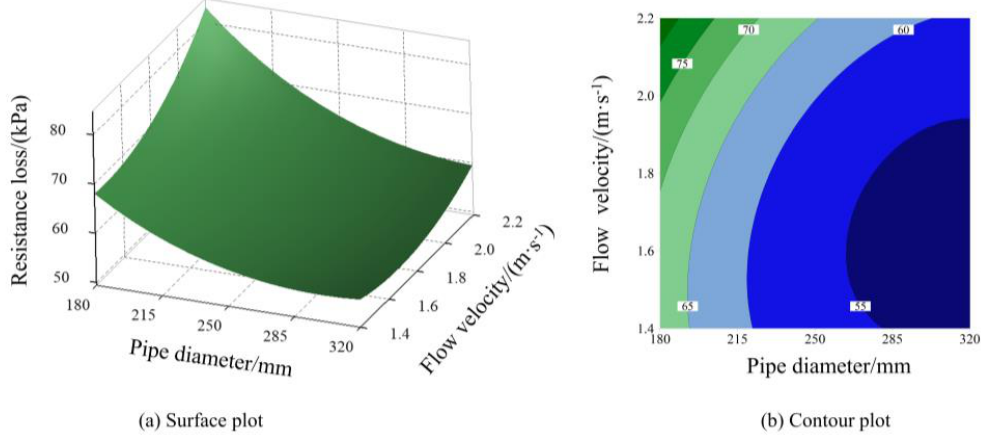
Figure 11. Interaction of pipe diameter and inlet velocity with resistance loss: the other factor is held at the center level.